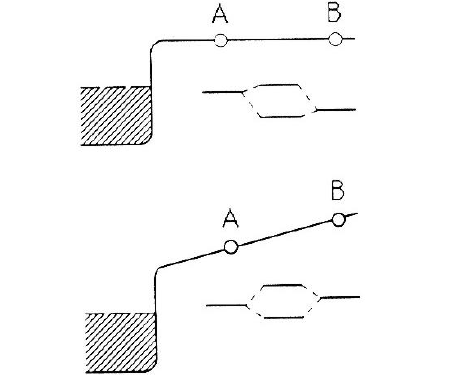
Figure 1. Schematic of a molecule AB at a metal surface without and with an electric field